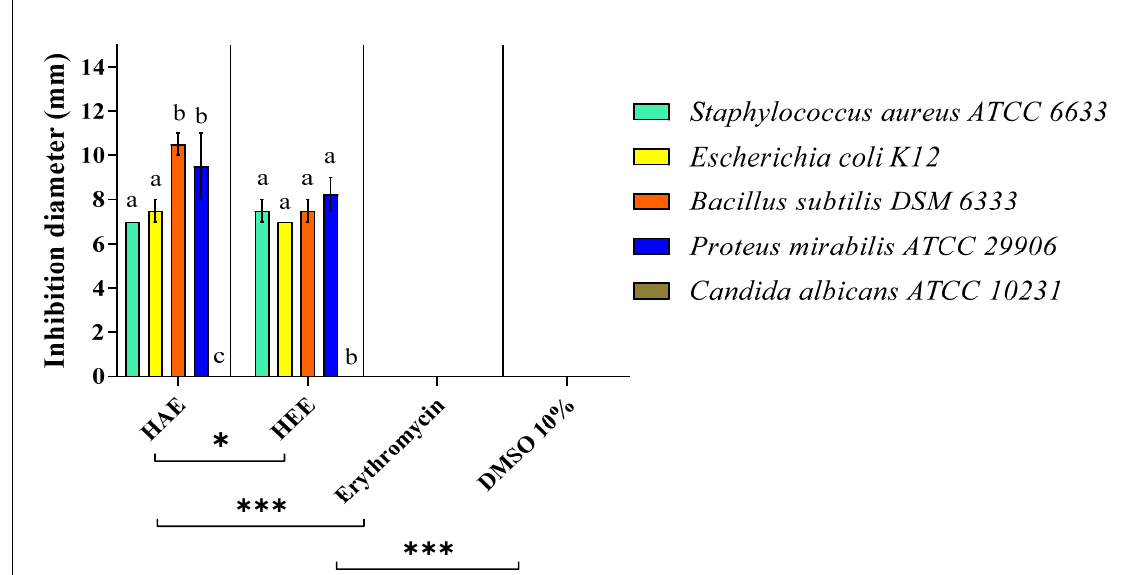
Figure 5. Antimicrobial activity of S. elaeagnifolium HEE and HAE in comparison with the antibiotic Erythromycin. Means (± SD, n = 3) denoted by the same letter indicate no significant difference according to Tukey’s multiple range tests at p < 0.05. The signs * and *** mean that there is a significant difference between the different samples and controls.